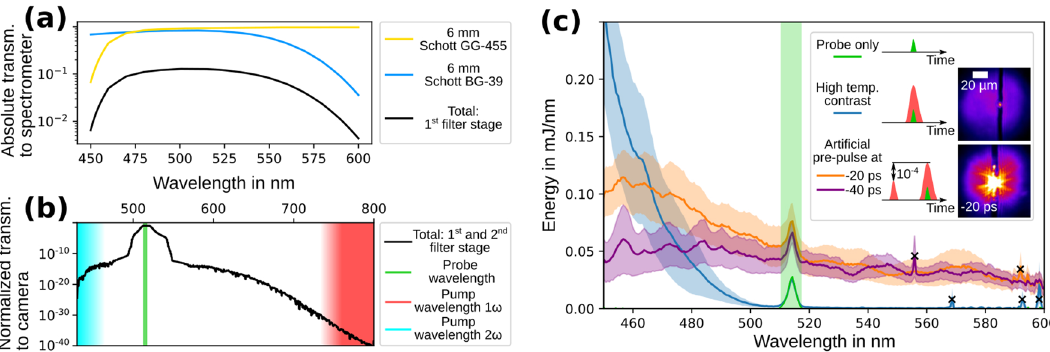
Figure 2. (a) Calculated absolute spectral transmission function from the target up to the spectrometer (refer Fig. 1) together with the individual transmission of the two colored glass filters; (b) Normalized transmission function up to the camera; (c) Spectral measurement of the plasma self-emission for three different laser contrast settings: High temporal contrast (blue) and artificial pre-pulse at − 20 ps (orange) and − 40 ps (violet) before the pump pulse. Each setting shows the mean over consecutive shots and the corresponding standard error of the mean as shaded area, the probe wavelength is marked by a green shaded area. Parasitic gamma-ray signals on the detector are marked by black crosses. Exemplary shadowgrams for high contrast and − 20 ps pre- pulse setting in the